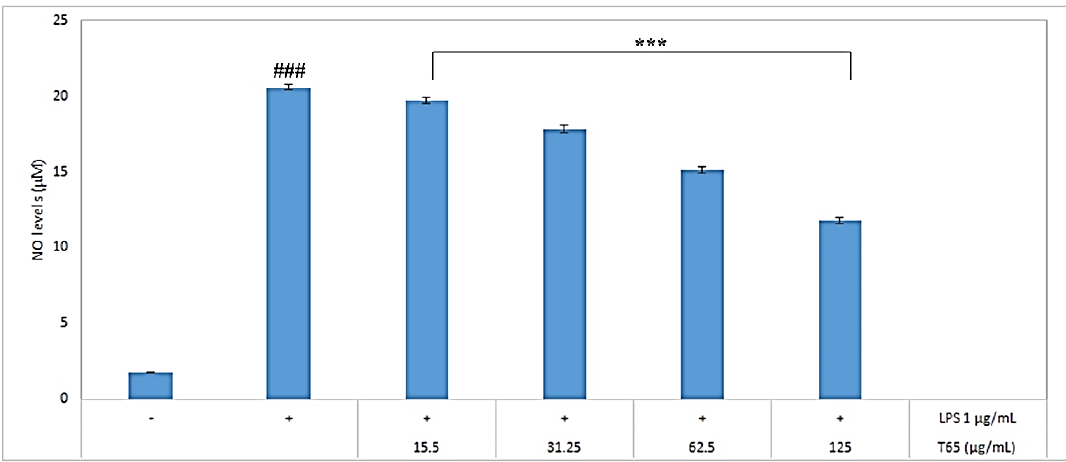
Figure 2. Evaluation of NO inhibition by T65 crude product. Values are given as mean ± SEM. ### p < 0.001 compared to untreated control and *** p < 0.001 compared to lipopolysaccharide (LPS) alone.